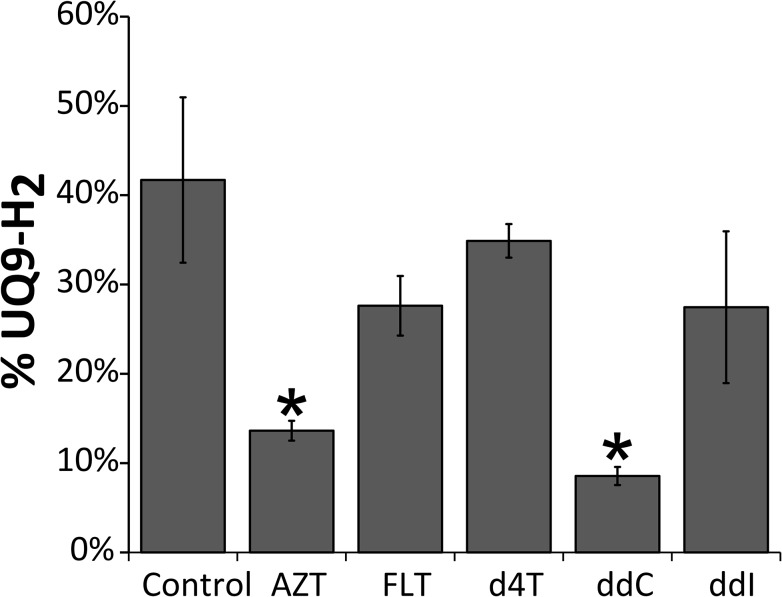
Quinone redox status is altered by some NRTIs.The redox state of the UQ9 pool is presented as percentage reduced (i.e. UQ9-H2) of the total UQ9 pool. Error bars indicate standard error. * = P ≤ 0,05.